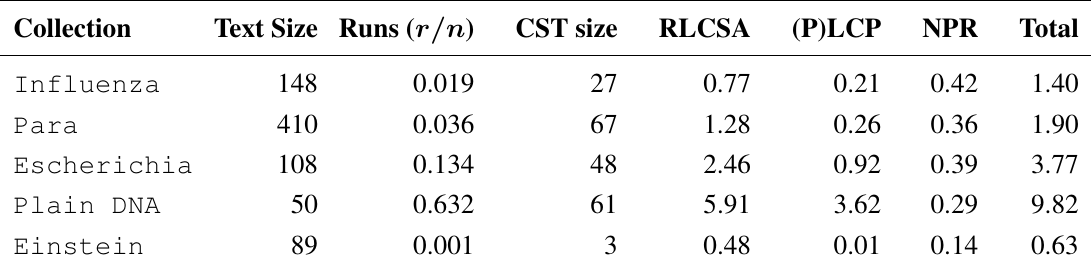
Table 4. Text size and size of our CST (which replaces the text), both in MB, and number of runs in Ψ . On the right, bpc for the different components, and total bpc of the different collections considered. The NPR structure is the smallest setting between RP-NPR and RPBal-NPR for that particular